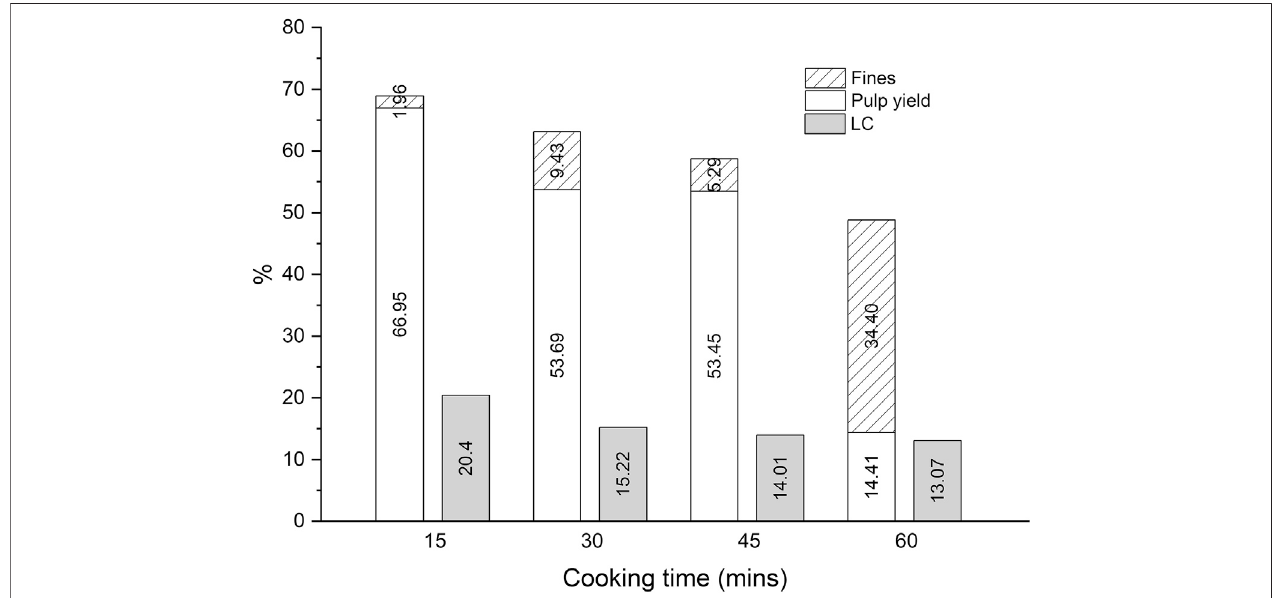
FIGURE3 | The effect ofthe cooking time on the pulpyield, fi nesand lignincontent in theDES-cooking ofAsplund fi bers (the L/W of27:1at 130 ° Cbyusing the RE setup).